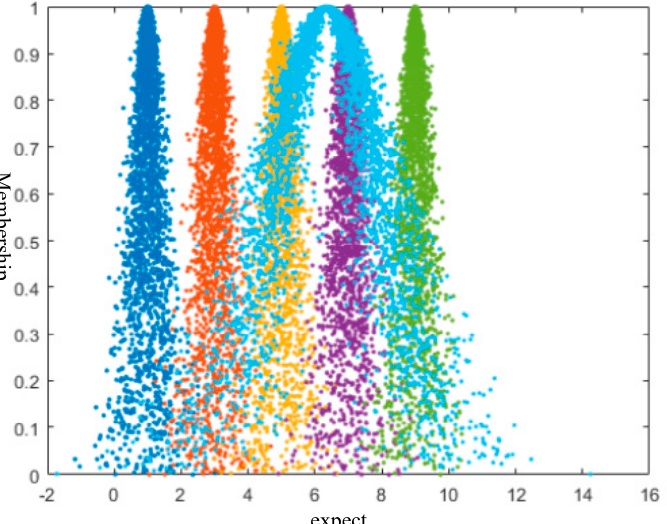
Figure 7. Comprehensive evaluation cloud chart of carbon emission reduction effect of prefabricated